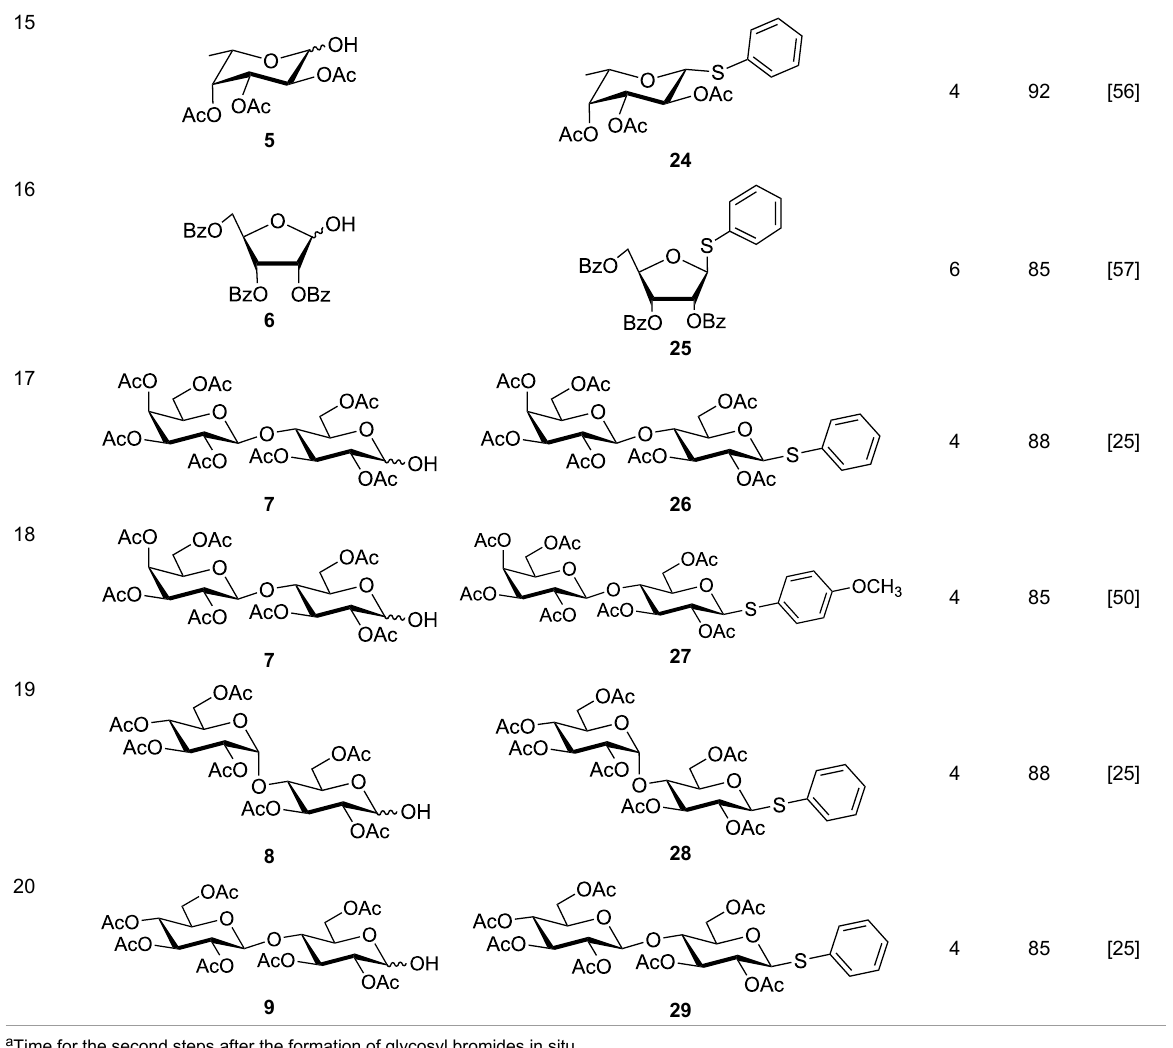
Table 3: Appel-reagent-mediated transformation of glycosyl hemiacetal derivatives to the thioglycosides at room temperature.